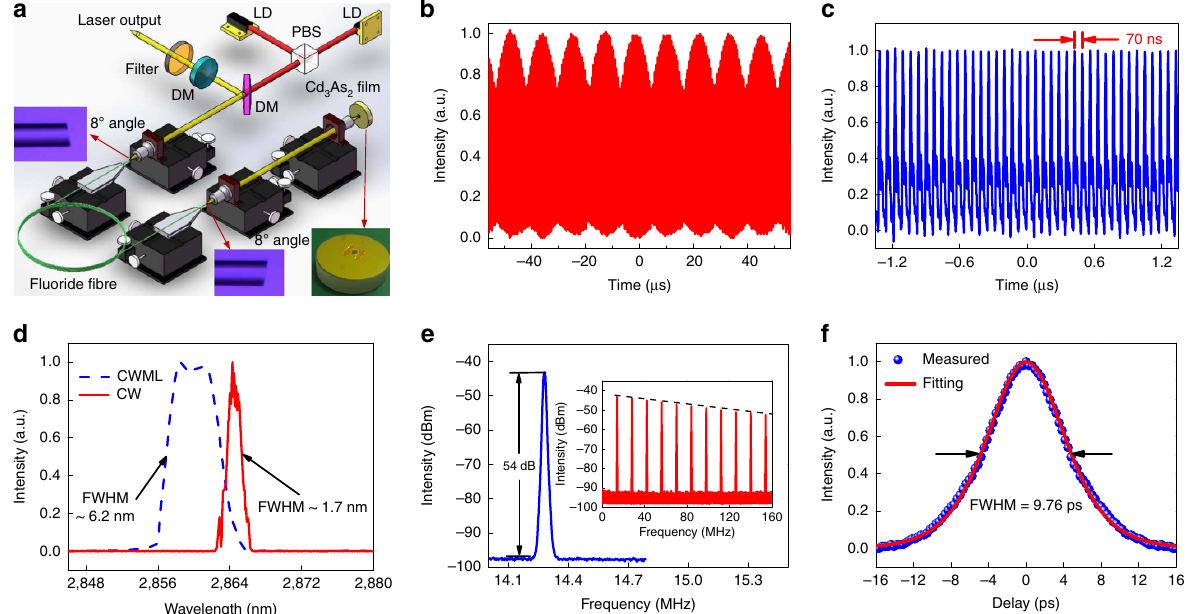
Figure 4 | Ultrafast mid-infrared fibre laser based on Cd 3 As 2 saturable absorber. ( a ) Schematic of the fibre laser setup, where LD, PBS and DM are diode laser, polarized beam splitter and dichroic mirror, respectively. ( b ) Q -switched mode-locked pulses at a pump power of 57.6mW. ( c ) CW mode-locked (CWML) pulses at a pump power of 286.9mW. There is no discernable envelope modulation, indicating stable operation. ( d ) Output optical spectrum. It is observed that the centre wavelength of CW operation (by moving the focussed beam onto a spot of the gold mirror clear of the Cd 3 As 2 sample) was red- shifted to 2864.3nm, as the decreased intracavity loss led to a lower initial Stark manifold of the 5 I 6 energy level. Meanwhile, the full-width at half- maximum (FWHM) was decreased to 1.7nm as a result of fewer required spectral Fourier components. ( e ) Radio-frequency (RF) spectrum at a scanning span of 0.8MHz with a resolution bandwidth of 10kHz. The repetition rate and signal-to-noise ratio were 14.28MHz and 54dB, respectively. The inset shows the RF spectrum with a broader scanning range from 0 to 160MHz. The smooth roll-off of the clean harmonic frequency components indicated that no Q -switched modulation and multiple pulsing were presented in this operation regime. ( f ) Autocorrelation trace measured with an intensity autocorrelator. The blue points are the experimental results and the red line is the fitting result using a Sech 2 function. The FWHM of the autocorrelation trace is 9.8ps, corresponding to a pulse duration of 6.3ps (a deconvolution factor of 1.54 is used to account for the Sech 2 pulse shape). For b – d , f , the intensities are normalized by the maximum value of measured physical